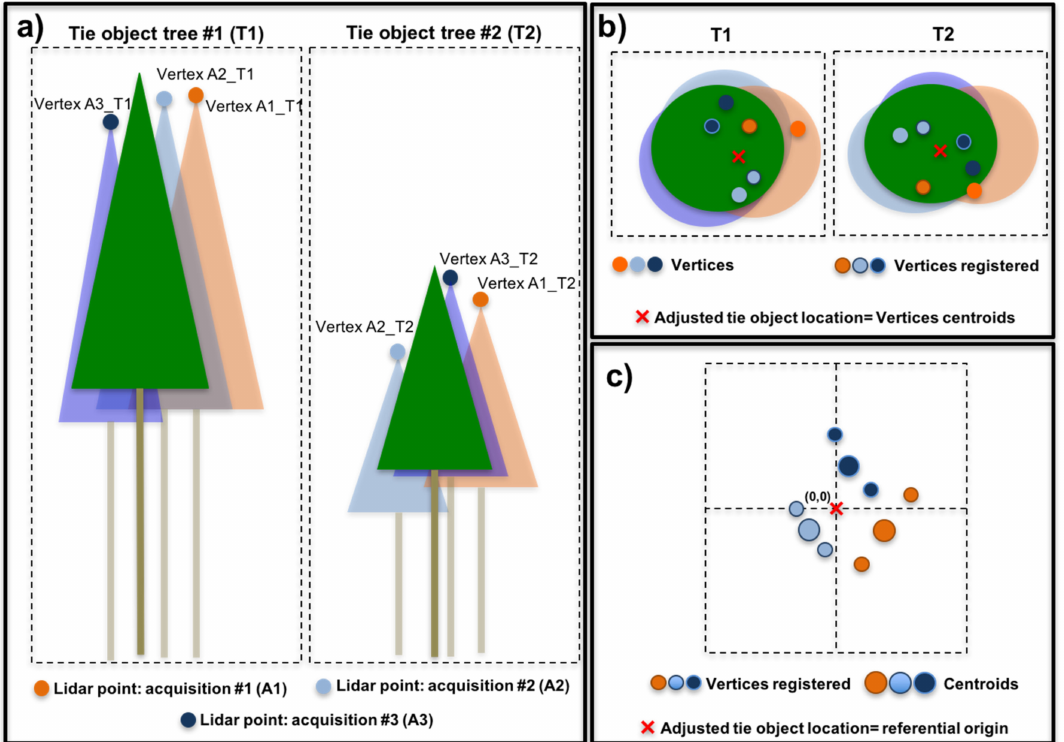
Figure 3. Schematic of the lidar registration methodology showing ( a ) two isolated trees selected as tie objects (green trees referred as T1 and T2) and the highest lidar points (called vertices) from three different lidar acquisitions (referred as A1, A2, and A3) that define the location of the corresponding trees (orange, cyan and blue trees), which are offset from the apex of the tie object, (i.e., the green tree in the foreground). In ( b ), we represent the location of the original vertices and corresponding centroids (red cross) that are used to calculated the adjusted (or registered) vertices. The colored large semi-transparent circles follow the colors in ( a ) and represent the trees from an aerial view. The diameter of the circles is figurative and has no physical meaning. In ( c ), we show the coordinates of the adjusted vertices and corresponding centroids that are reduced to a local referential (with origin in (0,0)). The coordinates of the centroid give us an estimation of the magnitude and direction of the misalignment for each lidar acquisition (please refer to Section 3.2 for details regarding ( c